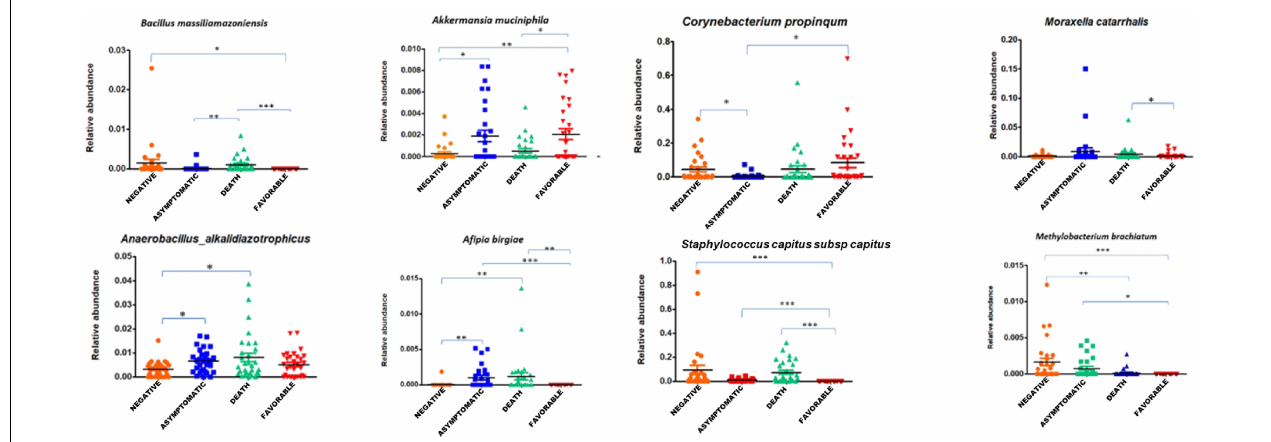
FIGURE 2 | Association of specific taxa in the airway microbiota of COVID-19 patients. The relative abundance of differentially enriched taxa in the four clinical groups of COVID-19 patients (negative, asymptomatic, deceased patients, and patients with a favorable outcome). Five pathogens enrichment in groups of SARS-CoV-2 positive subjects: Corynebacterium propinquum/pseudodiphtericum ( p ≤ 0.05), Moraxella catarrhalis ( p ≤ 0.05), Bacillus massiliamazoniensis ( p ≤ 0.01), Anaerobacillus alkalidiazotrophicus ( p ≤ 0.05), and Staphylococcus capitis subsp. capitis ( p ≤ 0.001). One-way ANOVA (Kruskal–Wallis statistic).